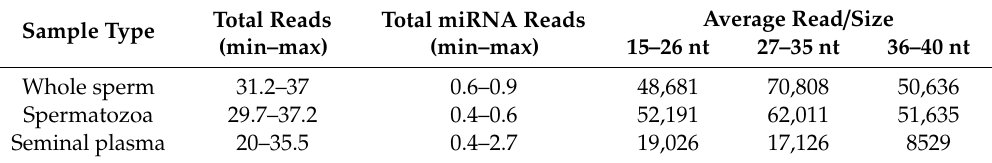
Table 1. Summary of sequencing depth (total reads, in millions), number of miRNA reads (in millions), and average read per size for three small RNA size groups, corresponding to putative miRNAs, putative Piwi-interacting RNAs (piRNAs), and other small RNAs, respectively. The average read / size is calculated using the number of total reads of a given size divided by a number of unique sequences in a given size.